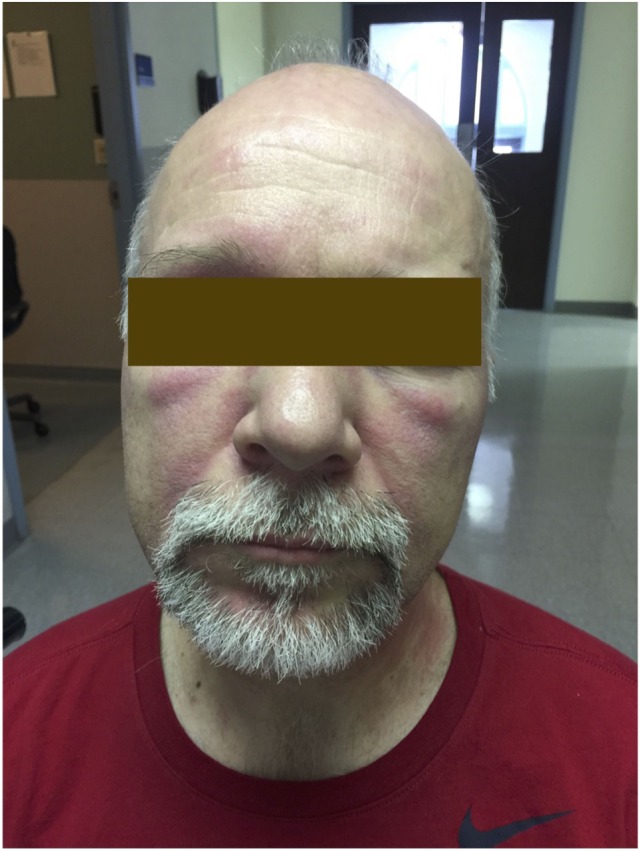
Heliotrope rash of dermatomyositis.